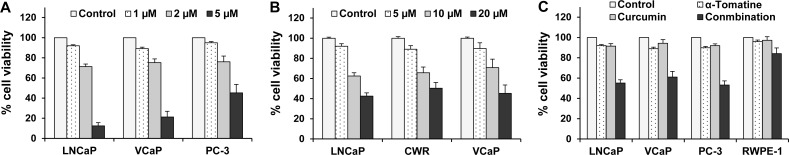
Effects of α-tomatine and curcumin alone or in combination on the growth of cultured prostate cancer cells.Human prostate cancer cells (LNCaP, VCaP and PC-3) and non-tumorigenic prostate epithelial cells (RWPE-1) were seeded at a density of 0.2 × 105 cells/ml in 35 mm tissue culture dishes and incubated for 24 h. The cells were then treated with various concentrations of α-tomatine and curcumin alone or in combination for 72 h. Viable cells was determined by the trypan blue exclusion assay. (A) Percent cell viability in the various cell lines treated with α-tomatine. (B) Percent cell viability in the various cell lines treated with curcumin. (C) Percent cell viability in the various cell lines treated with α-tomatine (1 μM) and curcumin (5 μM) alone or in combination. Each value represents mean ± S.E from three separate experiments.